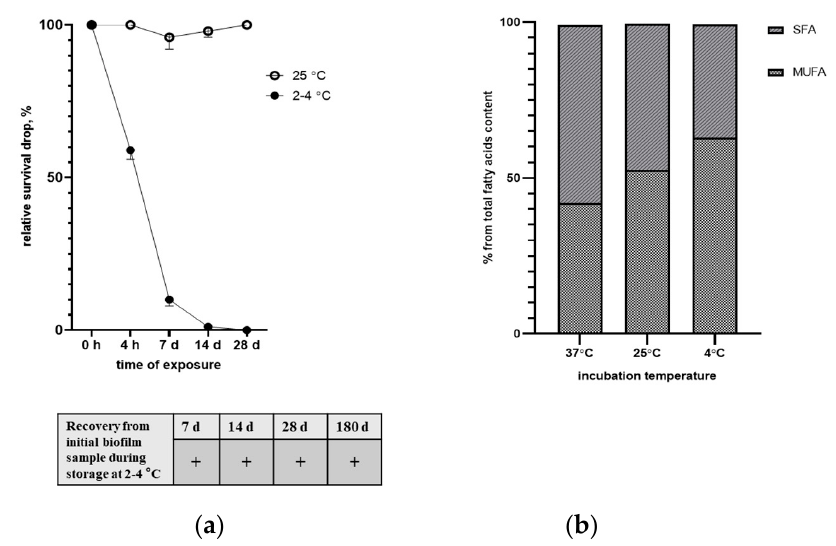
Figure 5. Influence of low temperatures on C. vaccinii . ( a ) Survival under exposure of liquid culture of C. vaccinii to sub-zero (2–4 °C) temperatures presented in %% relative exposure to 25 °C (presented as 100%) and recovery from the initial biofilm sample during storage at 2–4 °C. ( b ) Membrane fluidity adaptation through changing saturation of fatty acids during exposure to different temperatures.